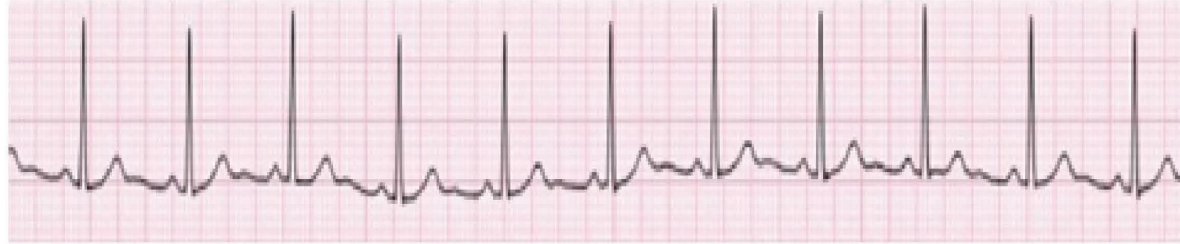
Figure 4: Crop ECG image.